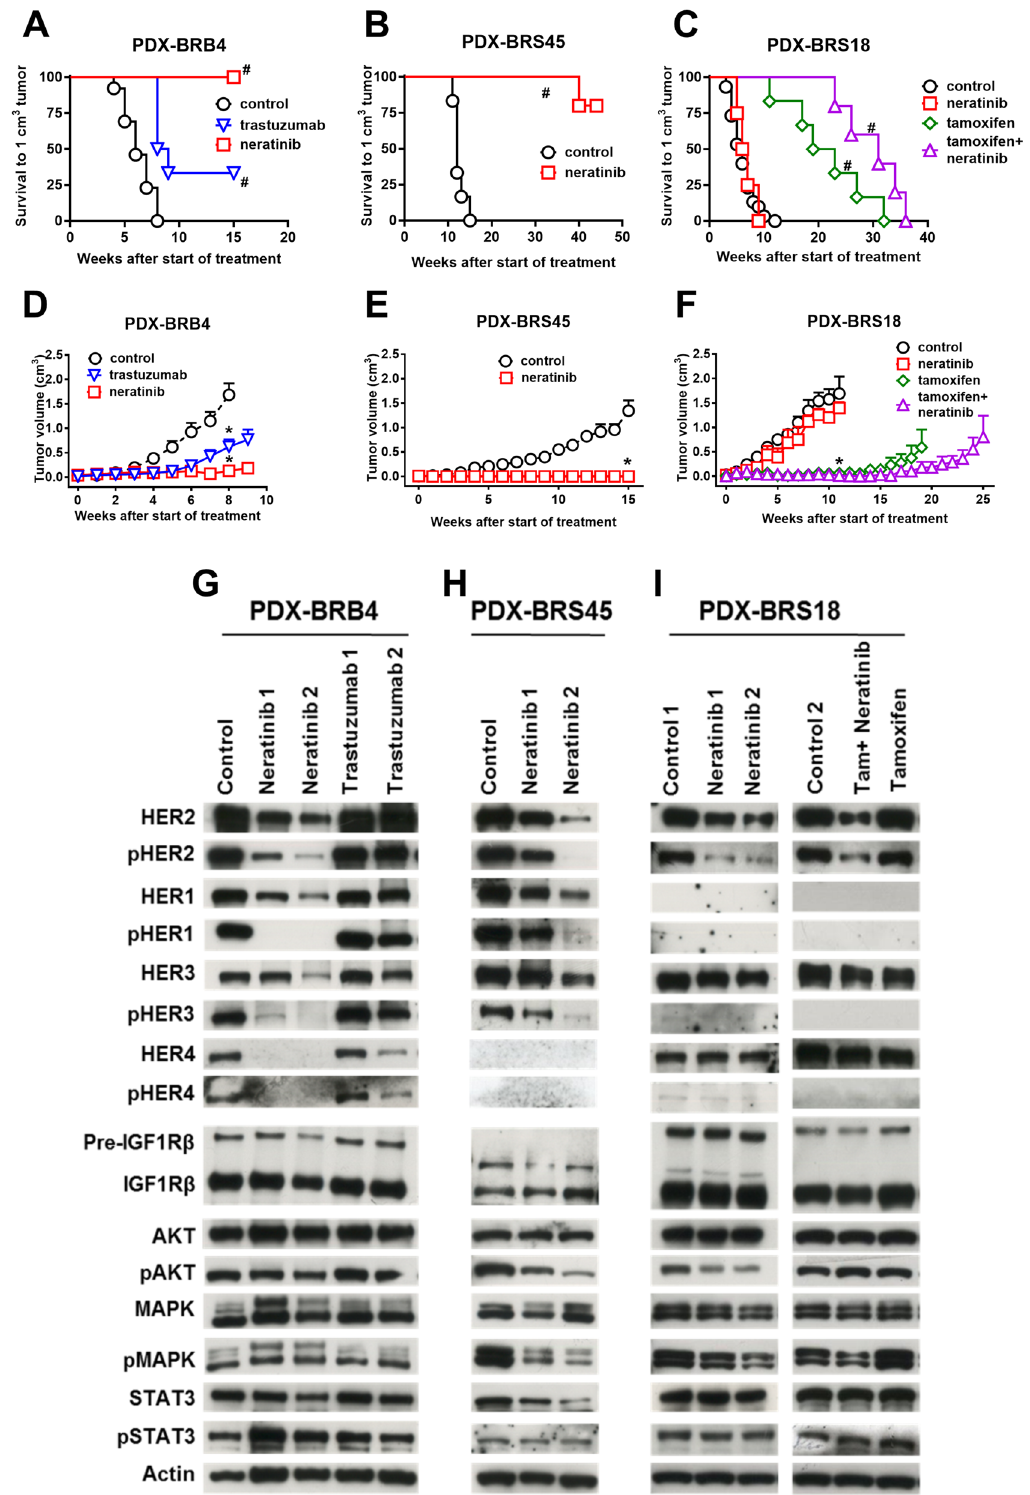
Figure 2. Effects on tumor growth ( A – F ) and downstream signaling ( G – I ) of HER2 targeted therapies in HER2-expressing PDX. Survival to 1 cm 3 tumor (Kaplan–Meier analysis, panels A – C ) and tumor growth curves (mean tumor volume and SEM, panels D – F ). Number of in vivo passages and mice: PDX-BRB4, passage 4–6, n = 6–13; PDX-BRS45, passage 5–6, n = 5; PDX-BRS18, passage 7–10, n = 5–20). Significance versus control: *p < 0.05; # p < 0.01. For tumor volumes, significance at each single time from week 5 onwards is collectively indicated by symbol on the curve. Effect of indicated treatments on signaling of PDX-BRB4, PDX-BRS45 and PDX-BRS18 (panel G – I , in vivo passages 14, 5 and 7–11, respectively). Replicates are from independent mice. Full-length blots are presented in Supplementary Figure